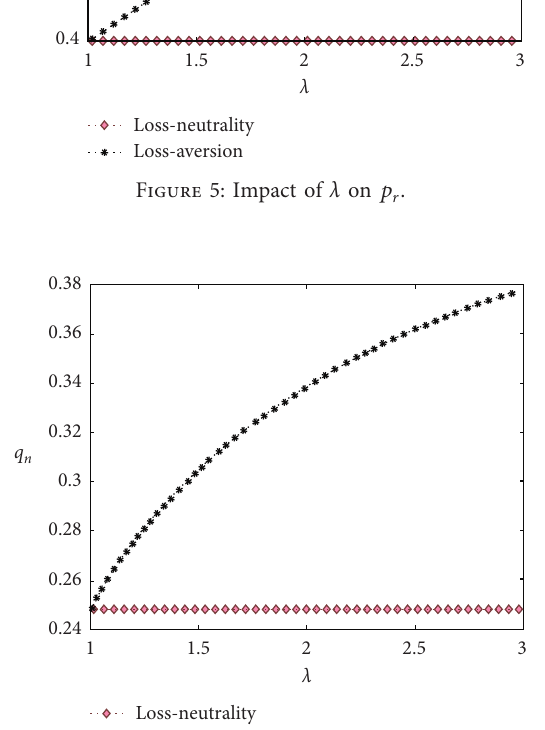
Figure 6: Effect of λ on q